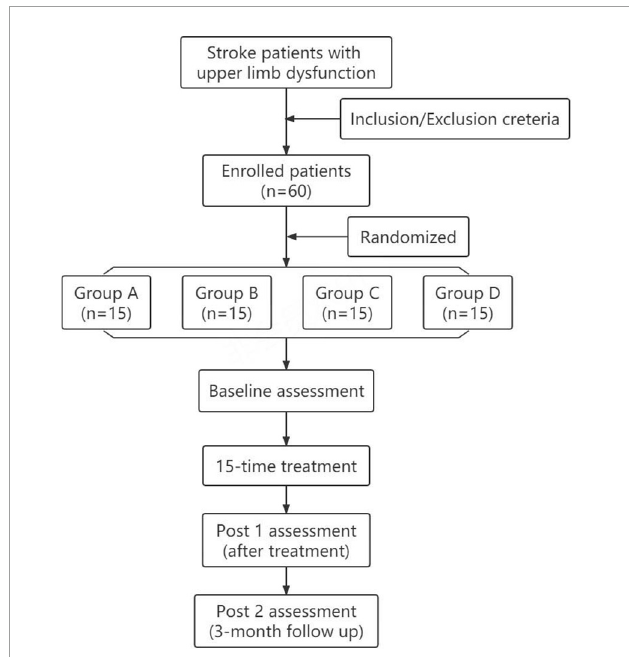
FIGURE1 Flowchart showing recruitment, group allocation, allocation treatment, follow-up and